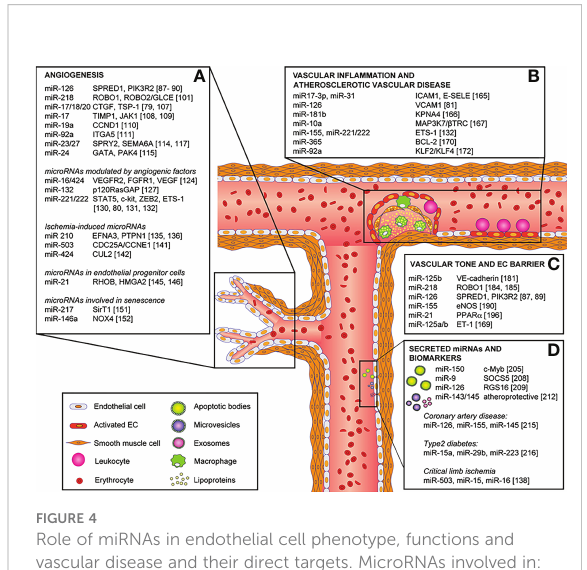
FIGURE 4 Role of miRNAs in endothelial cell phenotype, functions and vascular disease and their direct targets. MicroRNAs involved in: (A) angiogenesis, (B) vascular in fl ammation and atherosclerotic vascular disease, (C) vascular tone and endothelial cell barrier, and (D) secreted microRNAs and biomarkers. Reproduced under the terms of the Creative Commons CC BY license published by Elsevier. The following original report is credited: Chamorro- Jorganes et al.